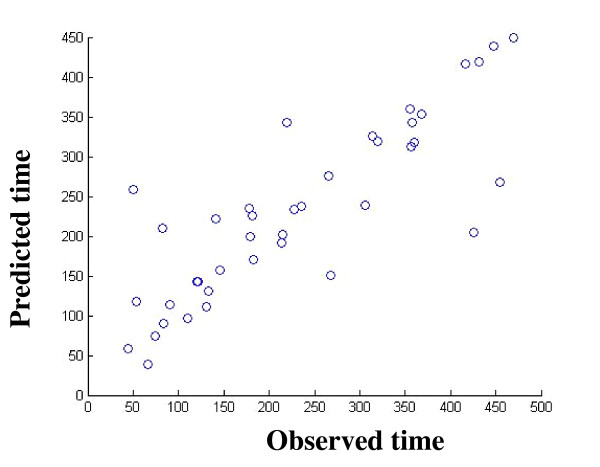
The predicted time to next relapse versus observed time of the next relapse (in days) for the best FTP. The graph demonstrates a very high correlation between these two values (Spearman correlation 0.82, p-value = 10-10).